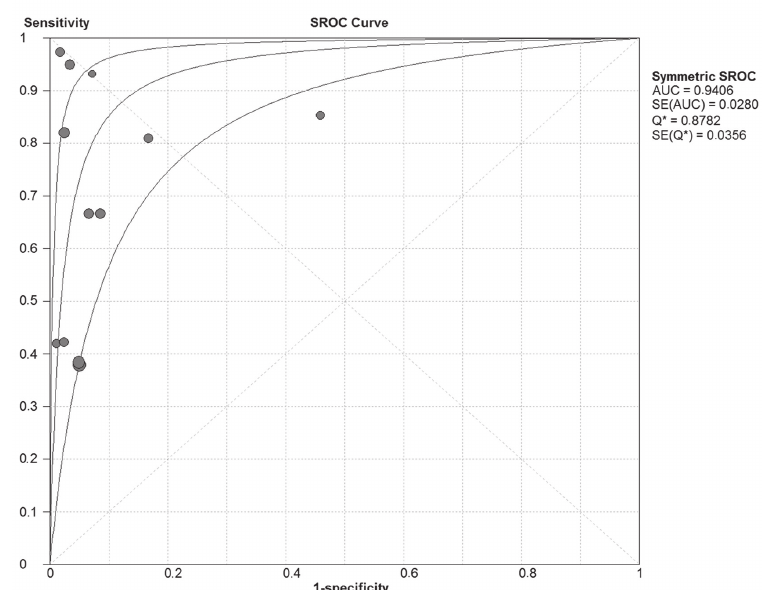
Figure 4 - Summary receiver operating characteristic curves